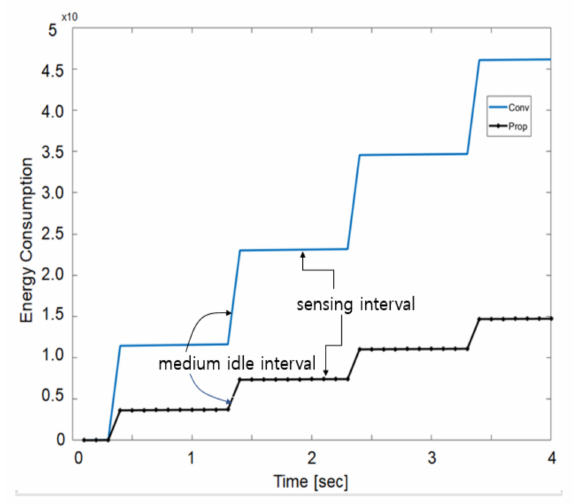
Figure 11. Node energy consumption in the sleep